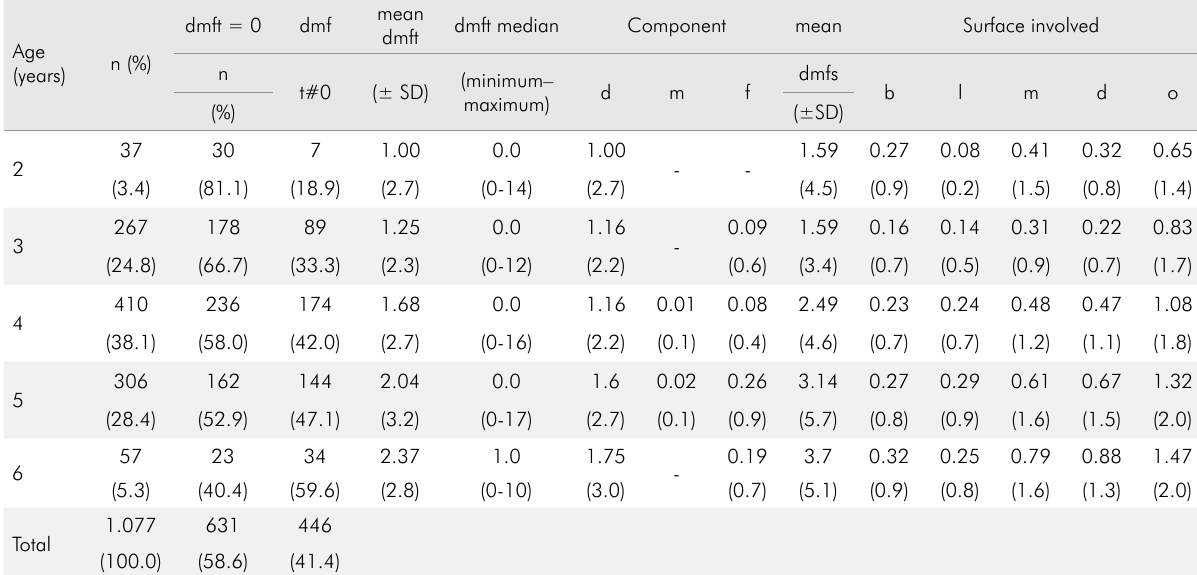
Table 1. Prevalence and severity of dental caries measured by mean dmft/dmfs by age